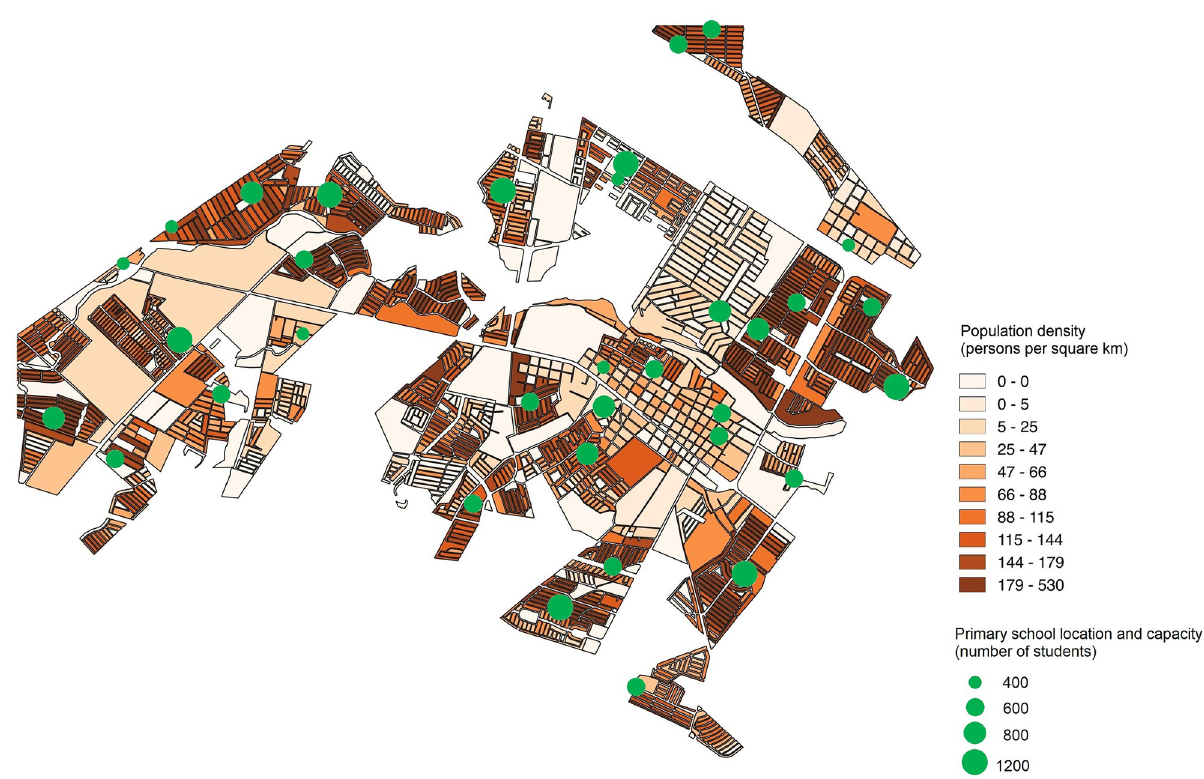
Fig 1. Population density and location of the 34 primary schools in Ciudad Benito Jua´rez in 2010.